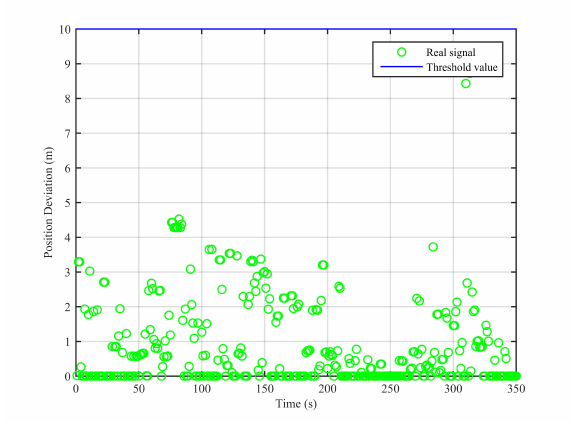
Figure 7. Position deviations of the two algorithms (clean static scenario).